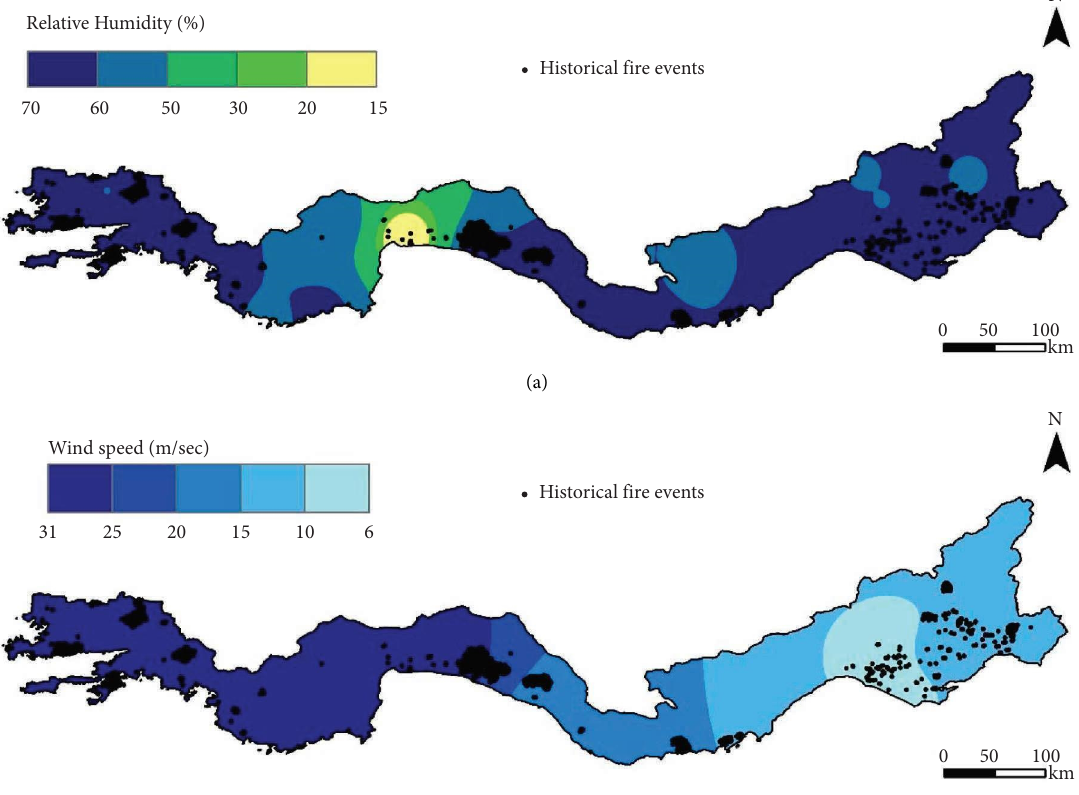
Relative Humidity